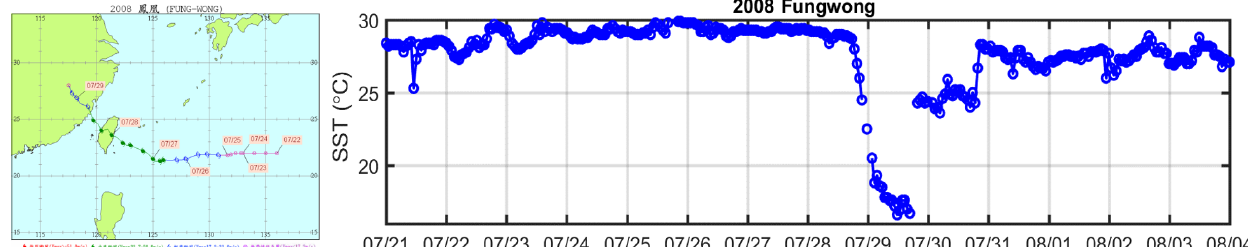
Figure A2. (2) Typhoon Fungwong in 2008, max (cid:49) SST = 12.5 ◦ C.